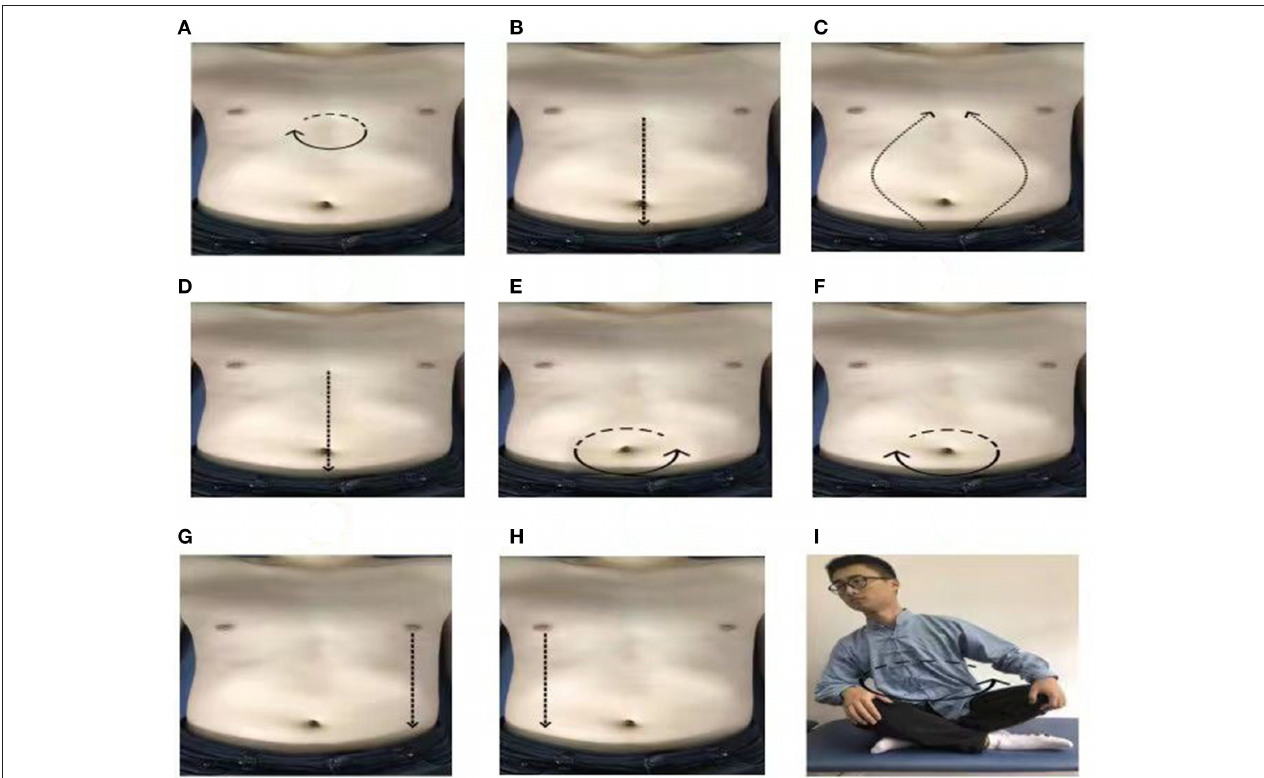
FIGURE 1 | The postures of PLWNT (34). (A) Press and knead acupoint in Danzhong. (B) Rubbing from Danzhong Acupoint to Pubic Symphysis. (C) Rubbing from Pubic Symphysis to Danzhong Acupoint. (D) Pushing from Danzhong Acupoint to Pubic Symphysis. (E) The right hand massages the abdomen by the left circle. (F) The left hand massages the abdomen by the right circle. (G) Pushing with the right hand from the left breast to the groin. (H) Pushing with the left hand from the right breast to the groin. (I) Turn left and right. Every movements will be carried out 21 times. PLWNT, prolong life with nine turn method.